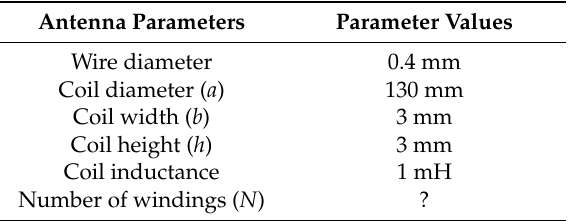
Table 5. The design parameters of the square coil